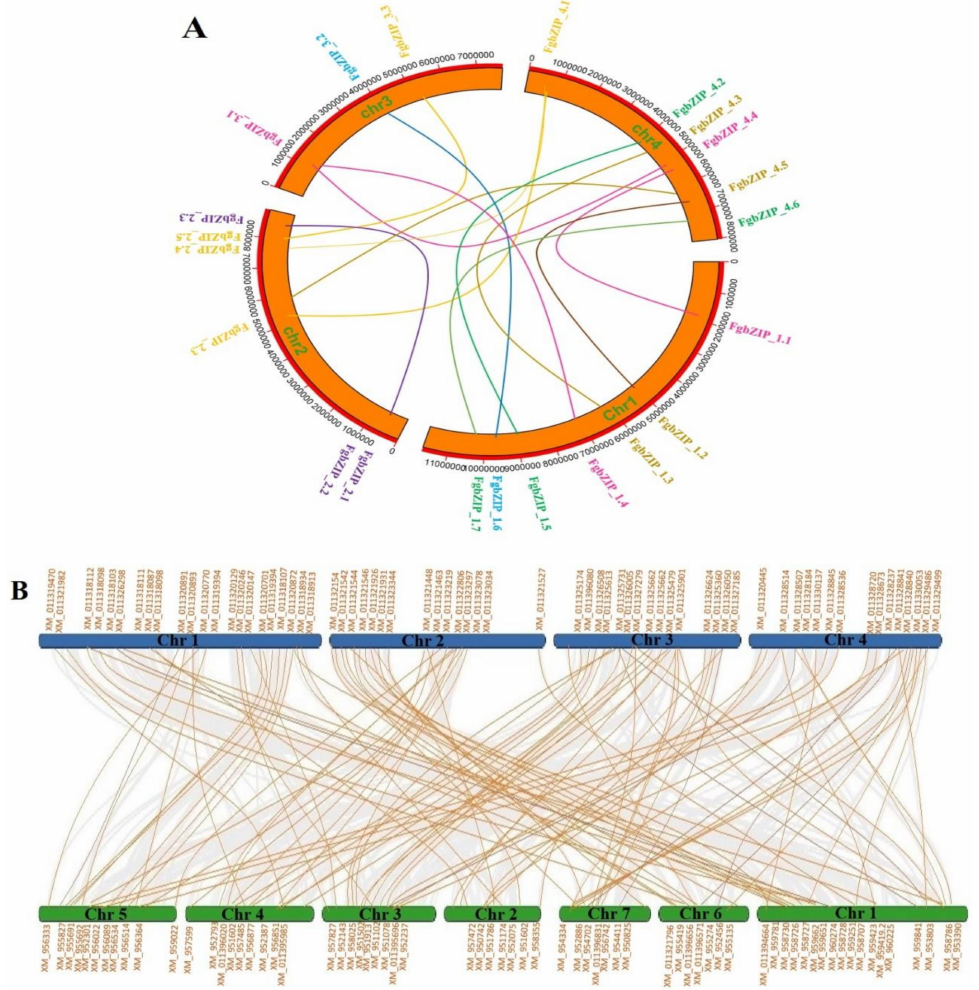
Figure 9. ( A ) Synteny analysis and chromosome localizations of F. graminearum (FgbZIP) genes (Paralogs). Block regions with orange color represent Fg chromosomes and genes indicated on a scale of bp paralogs colors and line pattern is according to phylogenetic trees clades displayed during gene structure analysis. ( B ) Synteny analysis (Orthologs) between F. graminearum whose chromosomes are indicated with blue color block and N. crassa whose chromosomes are indicated with green blocks, Supplementary File